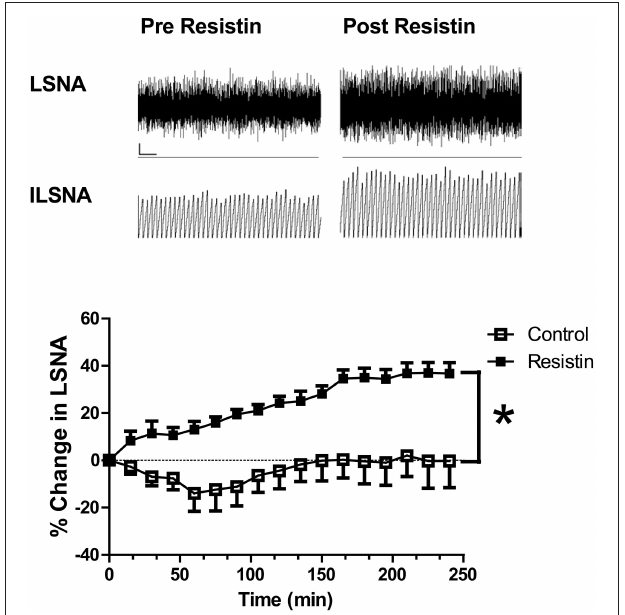
FIGURE 1 | Top: Screen capture of the raw recordings of lumbar sympathetic nerve activity (LSNA) and integrated lumbar SNA (ILSNA) before and after resistin (7 µ g) administered into the lateral brain ventricle of an anesthetized rat. x , horizontal bar = 2s, vertical bar = 100mV (LSNA), and 10mV.s (ILSNA). Lower: The percent changes in lumbar SNA from resting levels over 4h following resistin (7 µ g; n = 6 ) or control (artificial CSF; n = 7 ) administered into the lateral brain ventricle of anesthetized rats. * p < 0.05 between groups Two-way ANOVA. Modified from Kosari et al. (2011).